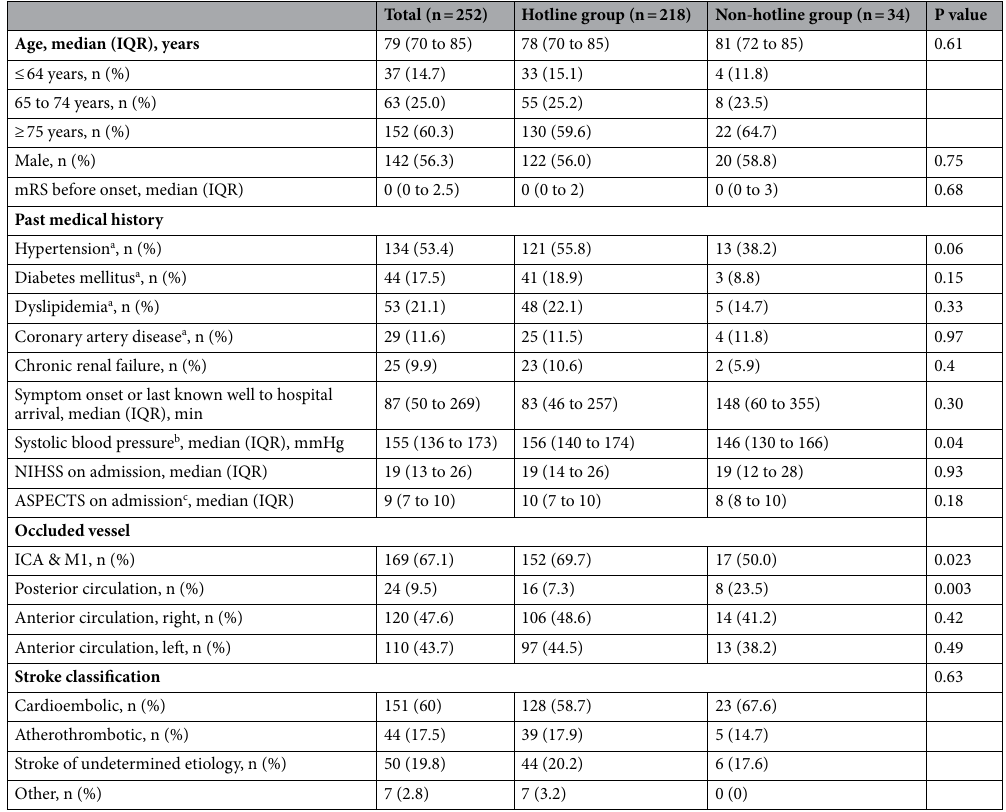
Table 1. Clinical characteristics of patients with large vessel occlusion who received endovascular therapy: hotline group vs. non-hotline group. IQR interquartile range, mRS modified Rankin Scale, NIHSS National Institutes of Health Stroke Scale, ASPECTS Alberta stroke program early computed tomography score, ICA internal carotid artery, M1 M1 segment of middle cerebral artery. Data were available for 251 patients a , 248 patients b , and 237 patients c .